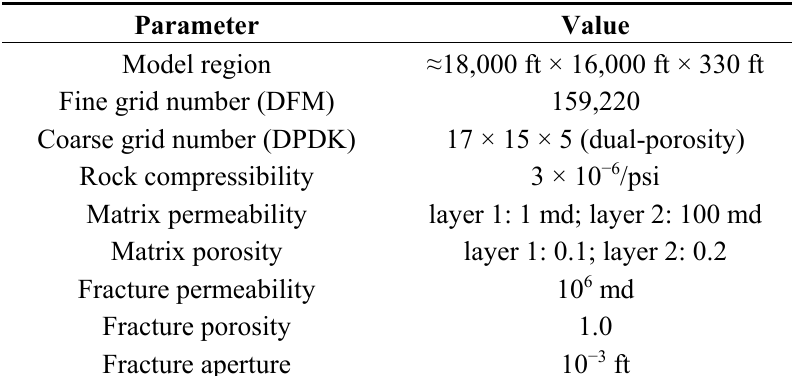
Figure 15. Case 3 model: ( a ) model overview; ( b ) fracture distribution. Table 5. Model parameters for case